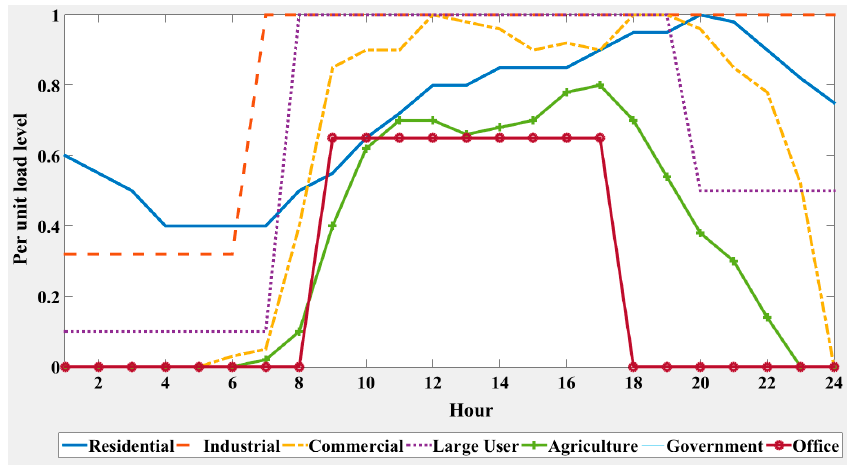
Figure 1. Various load sector curves. Table 1. Customer sector allocation (in MW) for the enhanced IEEE reliability test network (RTN). Bus Agri. LrgU Res. Govt. Ind. Com. Off.